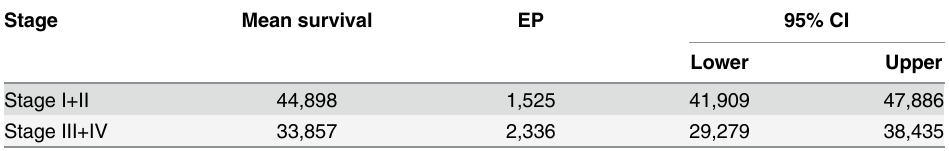
Table 9. Analysis of GS in relation to TNM stage.